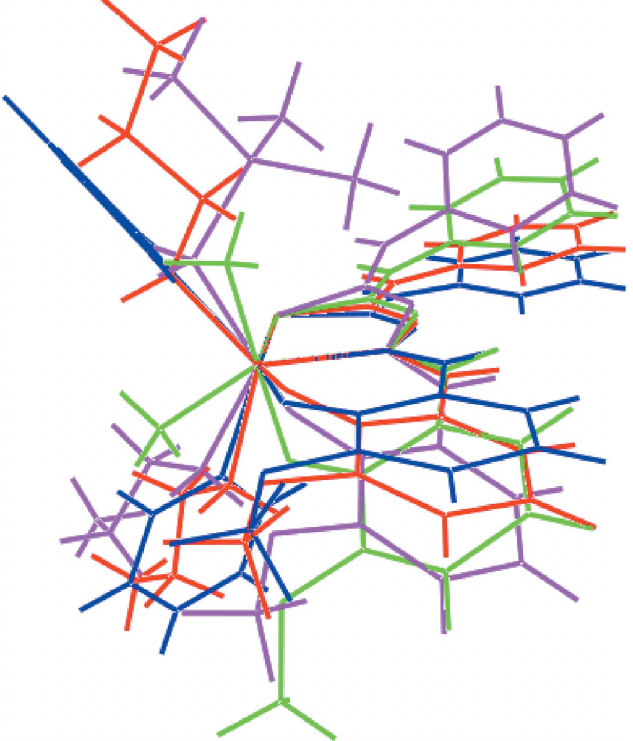
Figure 8 An overlay diagram of (I) red image, (II) green, (III) blue and (IV a ) pink. The molecules have been overlapped so that the Sn, S1 and N2 atoms of each molecule are